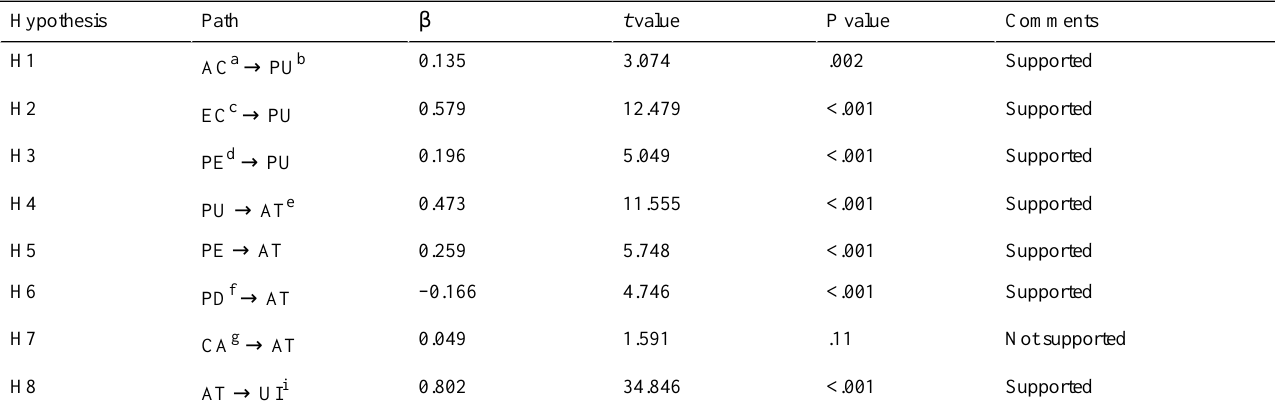
Table 5. Hypothesis analysis